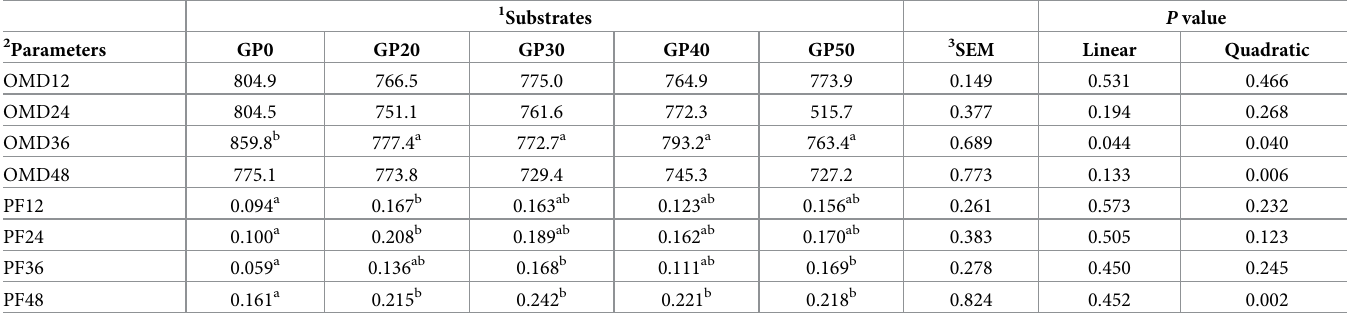
Table 4. Organic matter degradability (g/kg OM) and partition factors (ml/mg OM) of red grape pomace spent oyster mushroom substrate harvested at four weeks